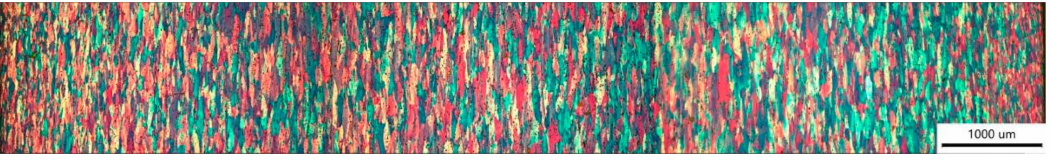
Figure 2. The polarized light microstructure of 5056 aluminum alloy drawn wires of ϕ 6 mm after being planed